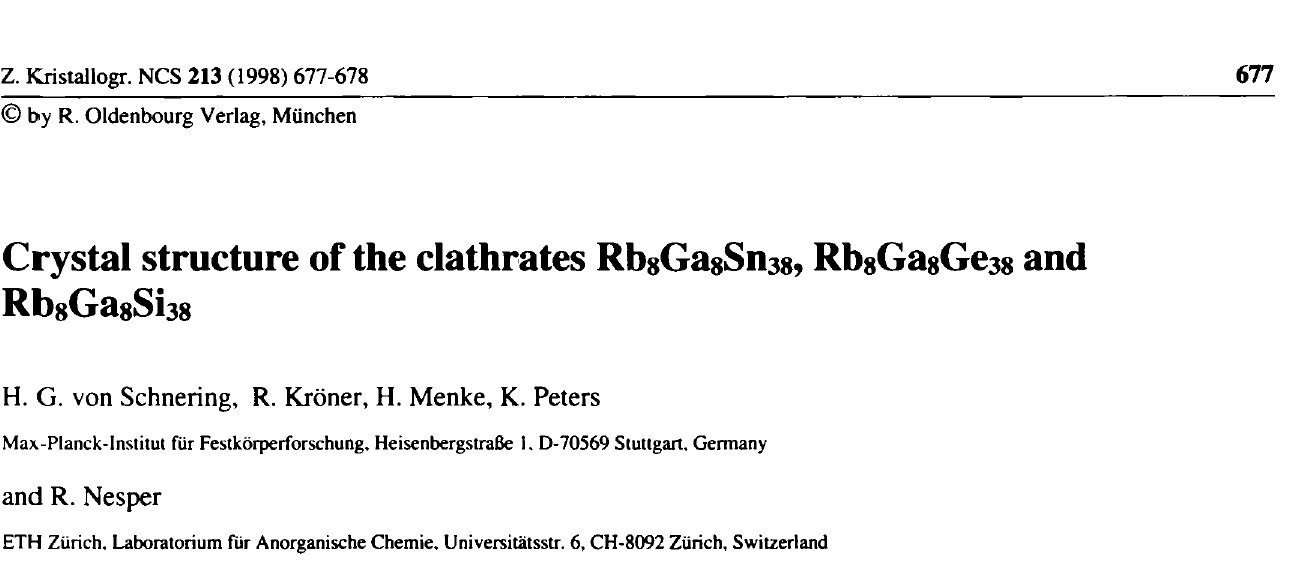
Source of material: Stoichiometric mixtures of the elements were sealed in Nb/Ta capsules under Ar, heated up to 1270 К (3 h), annealed at 970 К (2-3 d) and cooled down. RbgGasSnas forms well shaped crystals with many faces. The grey brittle compound is a semiconductor, stable in air and against dilute acids and bases (seeref. 1). The refinement of the site occupancies results in the composition RbgGanSn46-n with η = 8.17 + 0.60. Bond lengths in the E46 net (figure): d\ = 2.762(1) K dl = 2.791(1) Â, <0 = 2.825(1) À, dA = 2.748(1) Â.